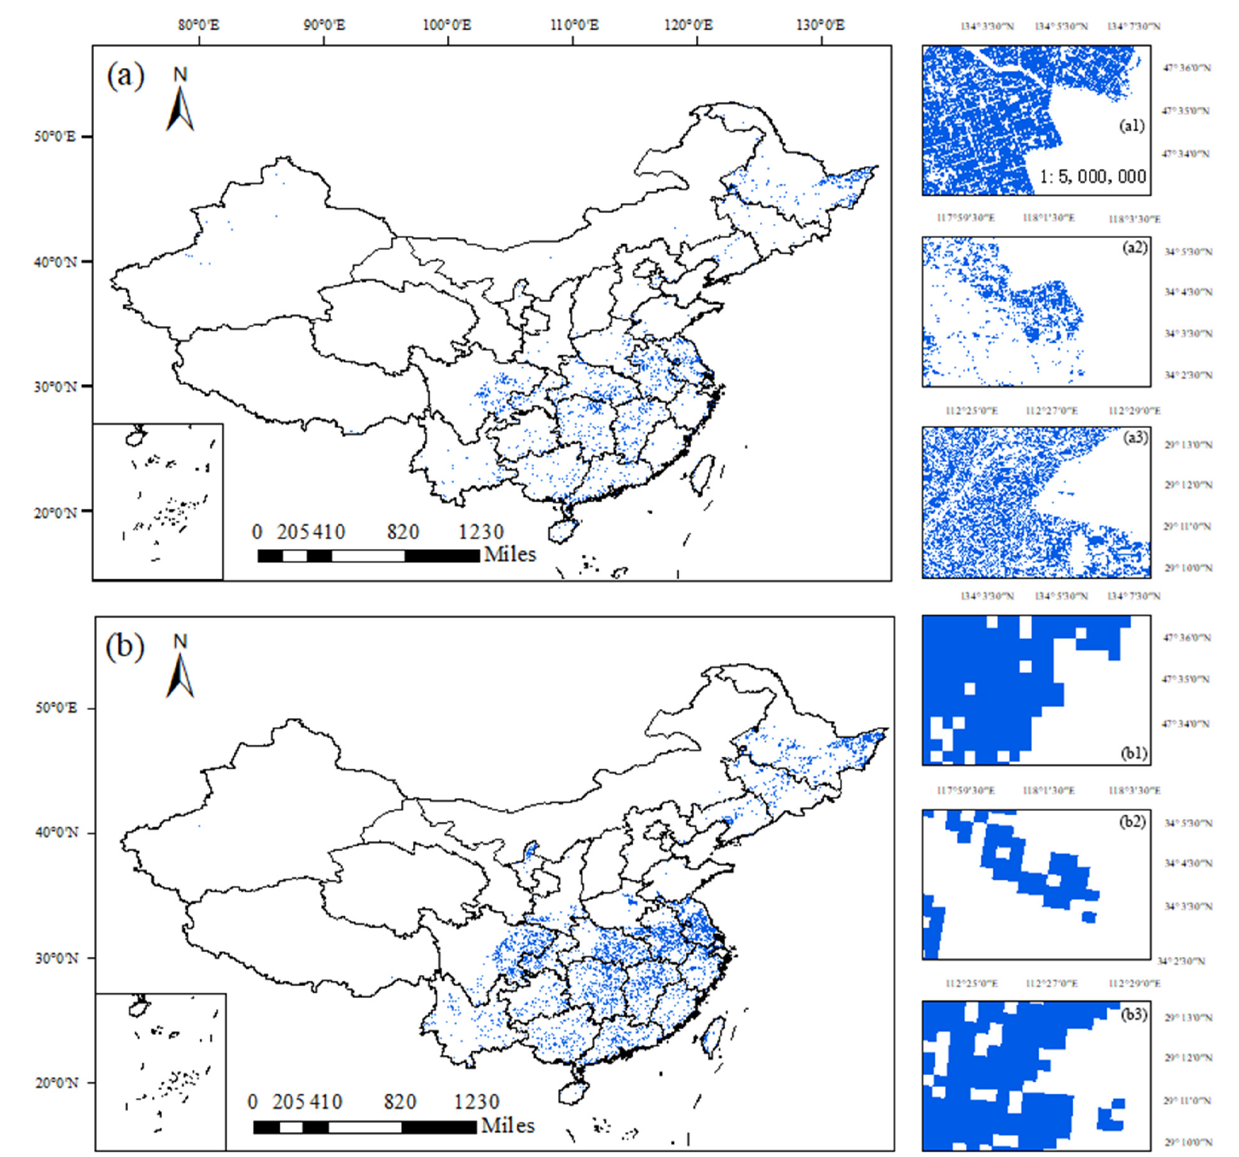
Figure 14. Comparison of the paddy rice map derived from EFSP(EFSP rice ) and Geographic Science and Natural Resources Research (NLCD rice ): ( a , b ) EFSP rice and NLCD rice , respectively; (a1), (a2), (a3), (b1), (b2), and (b3) are the magnified areas from the corresponding charts.